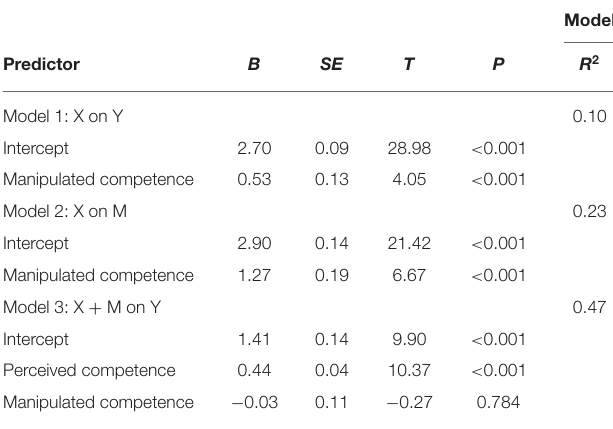
TABLE 4 | Mediated regression analysis testing the effect of manipulated competence on attributed trustworthiness mediated by perceived competence within study 1.